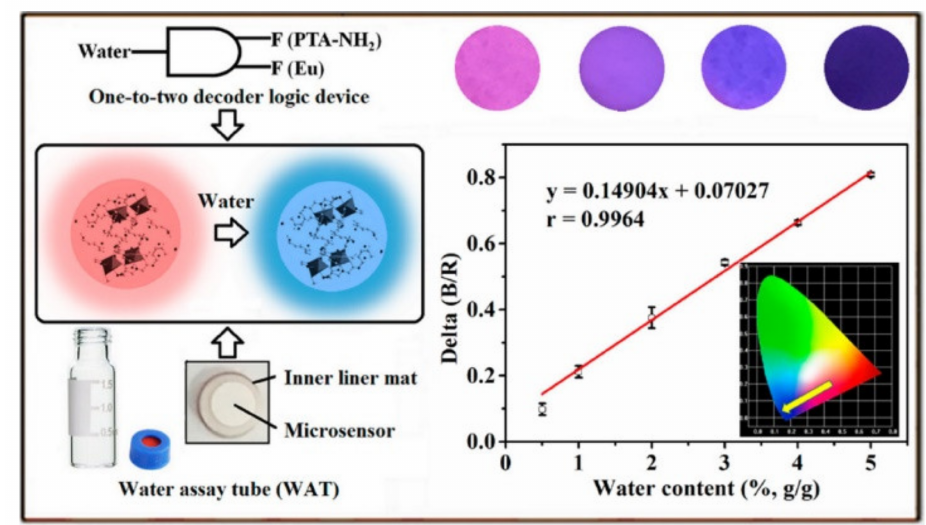
Figure 10. Schematic illustration of Eu-DPA/PTA-NH 2 -based portable analytical device for water analysis in solid samples. Reproduced with permission [153]. Copyright 2020, American Chemical